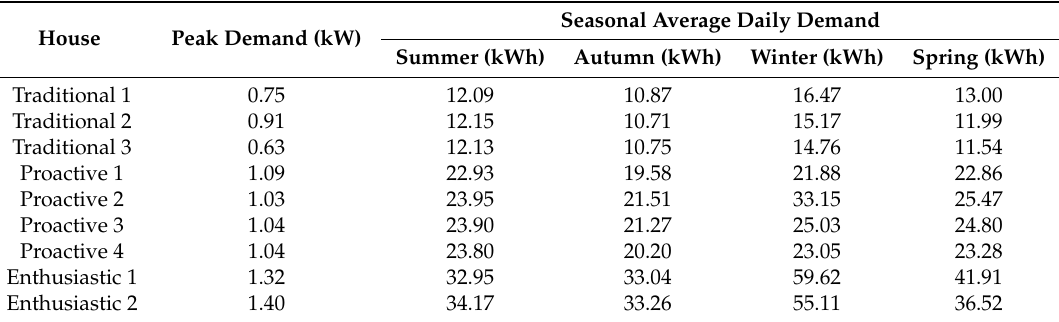
Table 5. Demand profiles of various households in the microgrid.